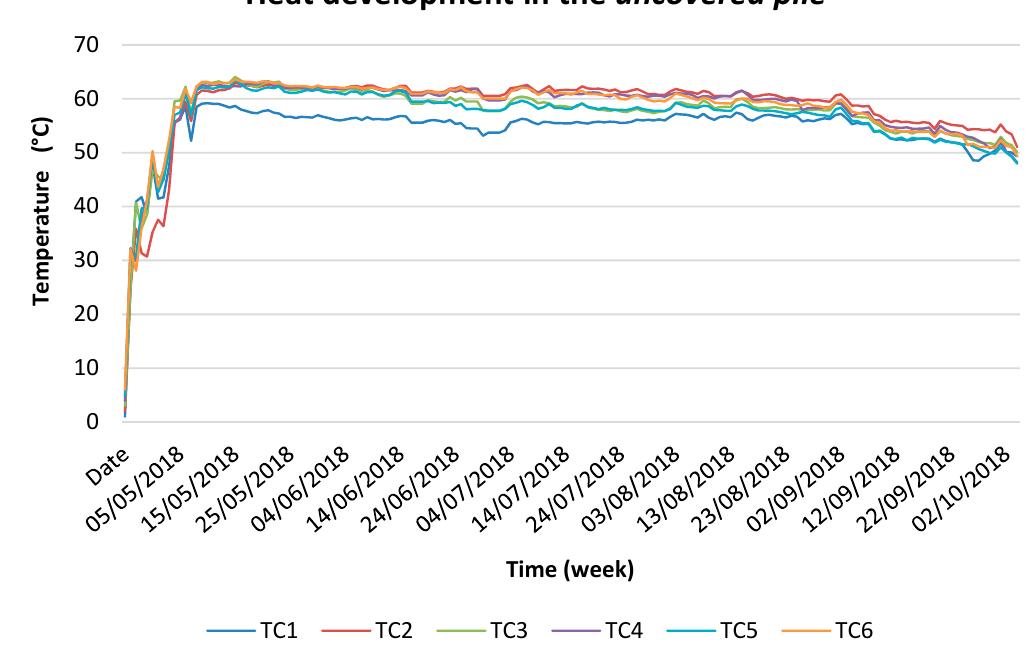
Figure 6. Heat development in uncovered pile. The numbered letters (TC1, TC2, etc.) indicate the thermocouple location according to the scheme shown in Figure 2.